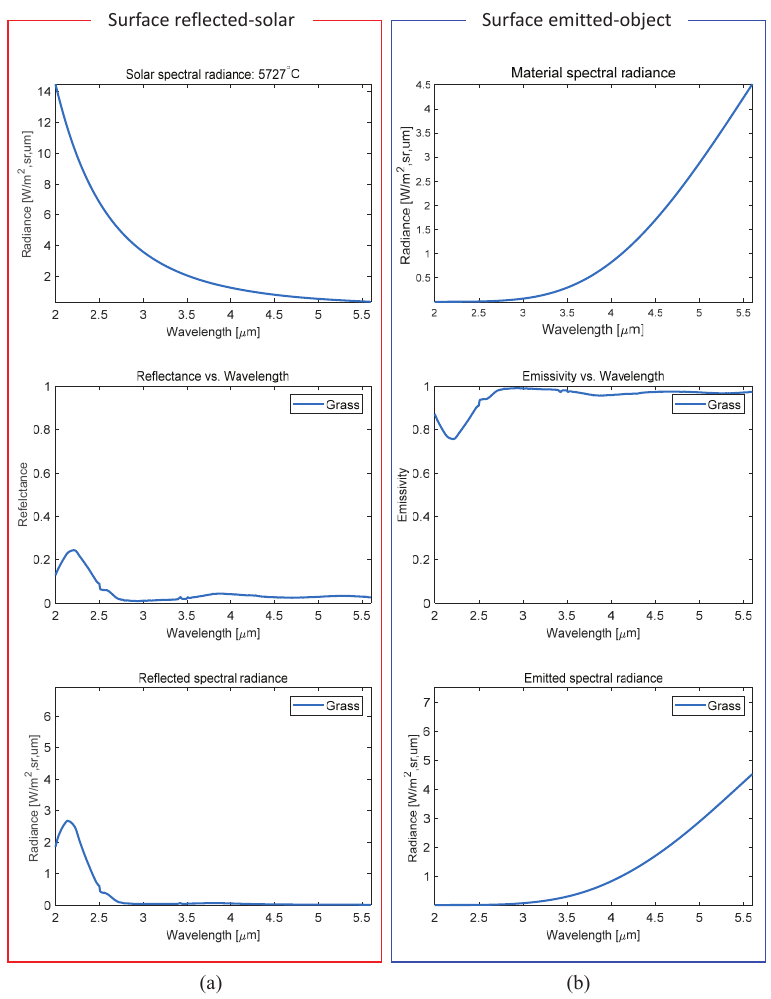
Figure 3. ( a ) Generation of surface reflected-solar, ( b ) generation of surface emitted-object. (1st row) solar radiance, object radiance, (2nd row) surface reflectivity, emissivity, and (3rd row) surface reflected-solar, surface